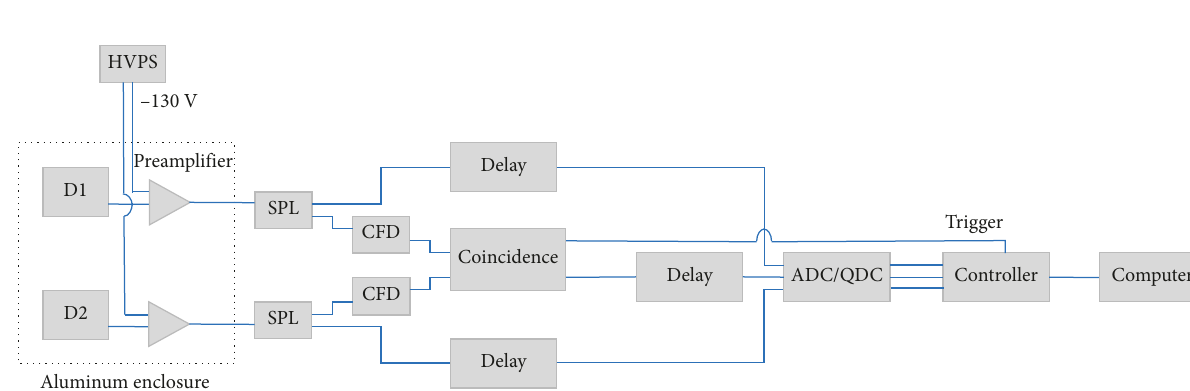
Figure 2: A schematic of the signal chain of the ∆ E / ∆ E detection